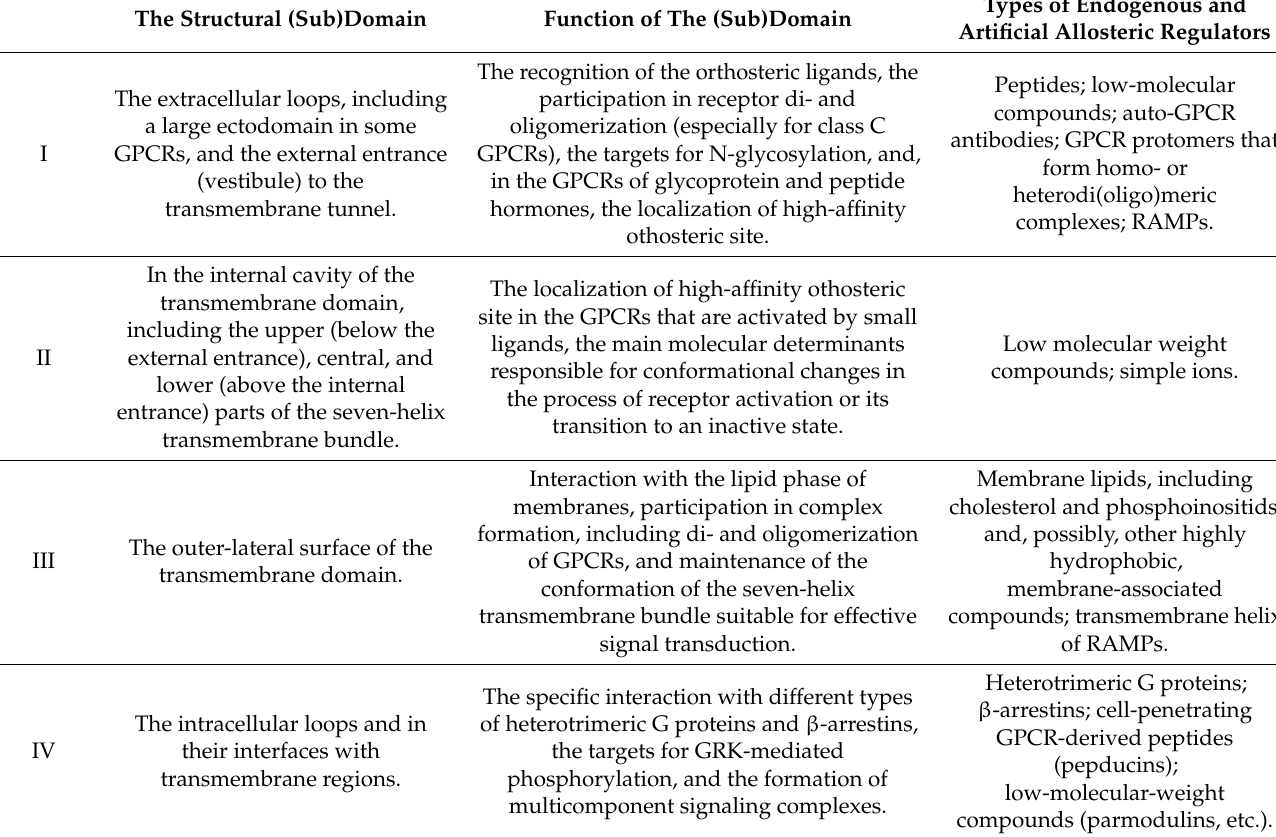
Table 2. Localization of allosteric sites in the GPCR and examples of ligands that are able to specifically bind to these